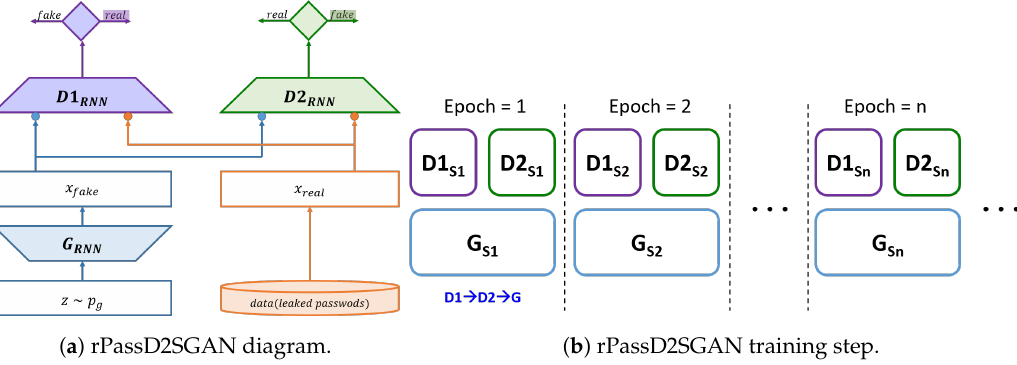
Figure 5. rPassD2SGAN block diagram and training step